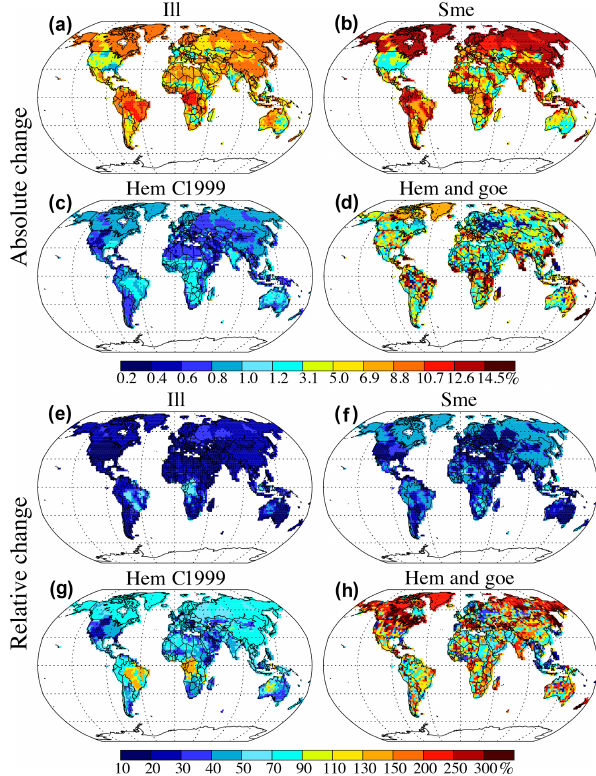
Figure 5. Changes in soil concentration (fractional amount) of il- lite (ill), smectite (sme), hematite (hem), and goethite (goe) in the clay category. In (a) , (b) , (c) , and (d) , values are derived by tak- ing the difference between high-bound mass fractions of the min- erals and their base values constructed following the method of Scanza et al. (2015) according to the MMT in C1999 (a, b, c) and J2014 ( d : hematite plus goethite) in CAM5. Similarly, (e) , (f) , (g) , and (h) show the relative change defined as (high bound- base) / (base) × 100. The mean soil distribution of these minerals has been shown previously (Scanza et al., 2015; Perlwitz et al., 2015a). Because of the limited information on mineral content in the silt-sized category, to create the global atlas for dust modeling showing the high and low bounds of iron oxides, we applied to all soil units a constant standard deviation of goethite that is present for two soil units for which we have